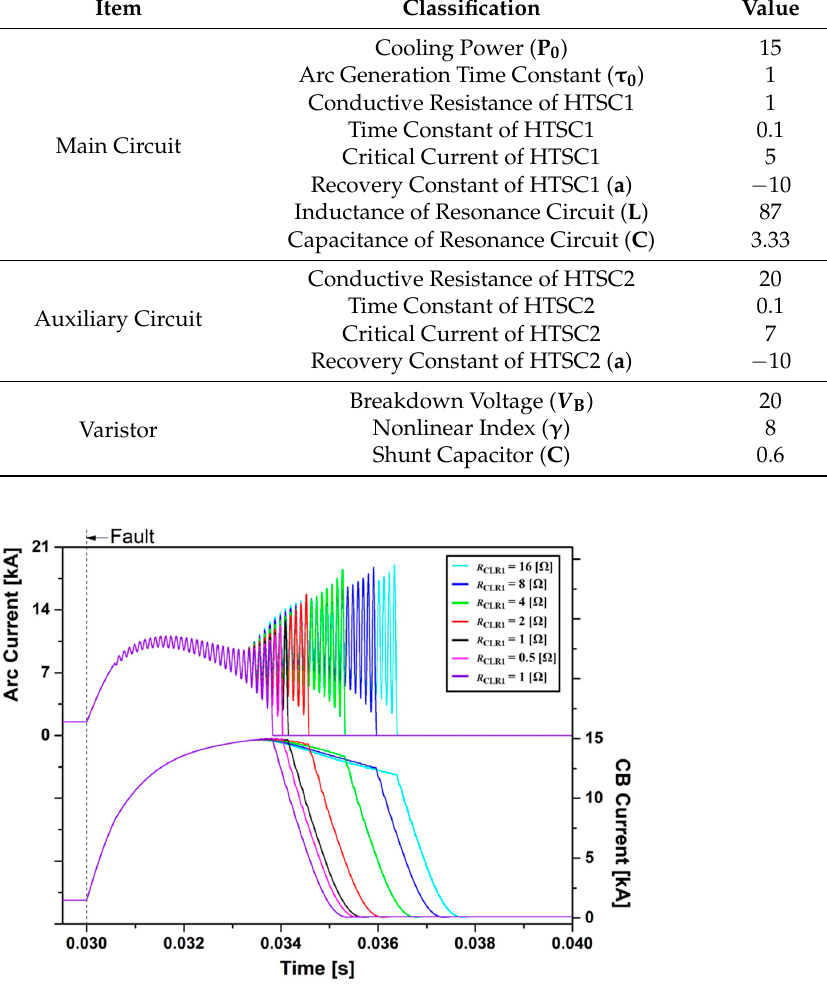
Table 2. Parameters of the proposed superconducting hybrid DCCB.